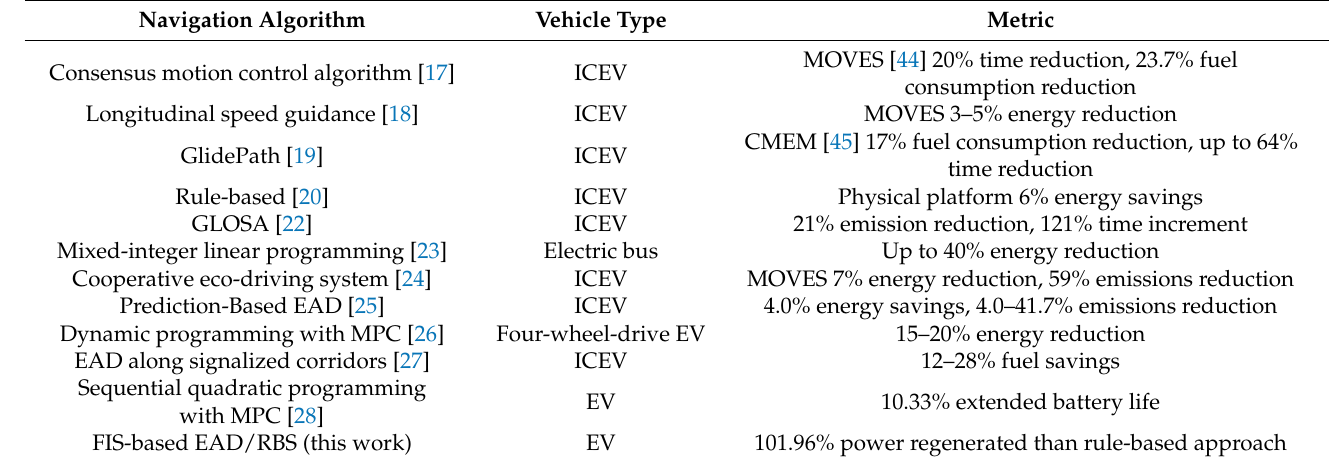
Table 1. Longitudinal navigation performance comparison.